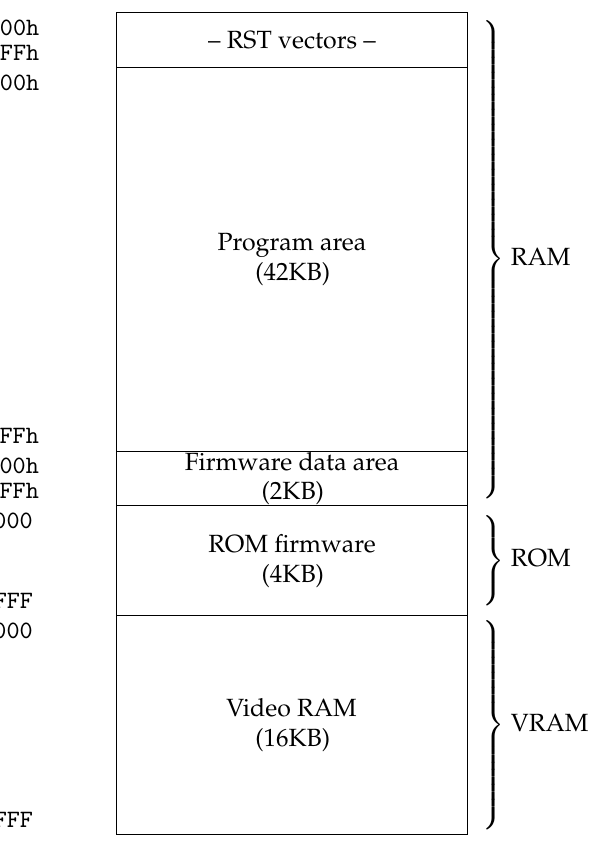
Figure 4. Dracon memory